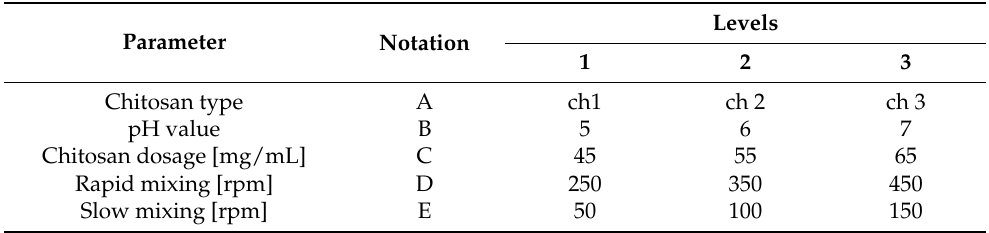
Table 1. The experimental factors and their levels during the flocculation of the Bacillus sp. BioSol021 cultivation broth. Levels Parameter Notation 1 2 3 Chitosan type A ch1 ch 2 ch 3 pH value B 5 6 7 Chitosan dosage [mg/mL] C 45 55 65 Rapid mixing [rpm] D 250 350 450 E 50 100